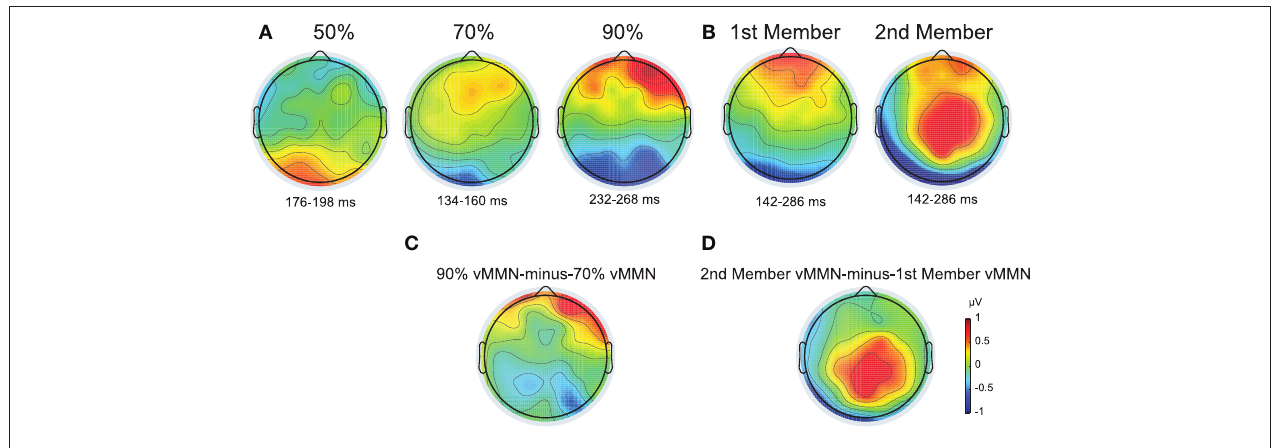
map of the 90–70% vMMN waveforms (measured in the 232–268 and 134–160 ms intervals, respectively). (D) Difference potential map of the